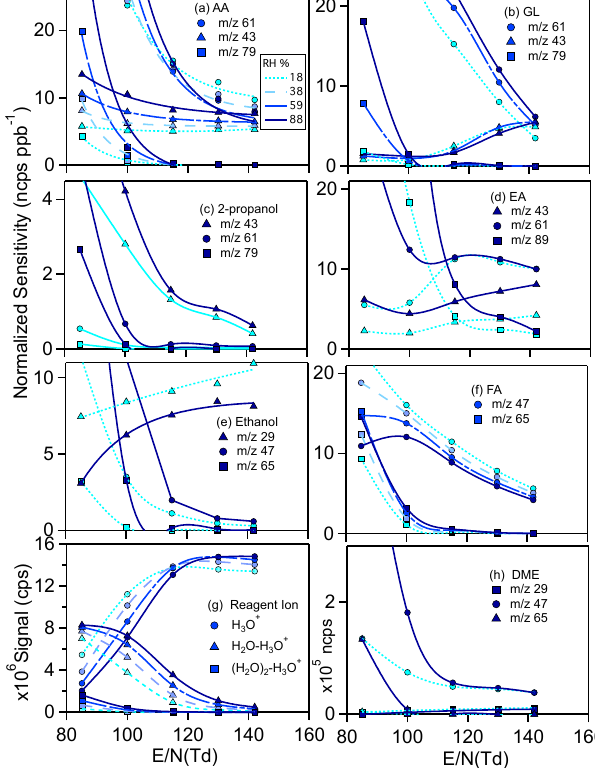
Figure 5. Distribution of major product ions originating from (a) AA, (b) glycolaldehyde (GL), (c) 2-propanol, (d) ethyl acetate (EA), (e) ethanol, (f) FA, (g) H 3 O + , and (h) dimethyl ether (DME) as a function of E/N and